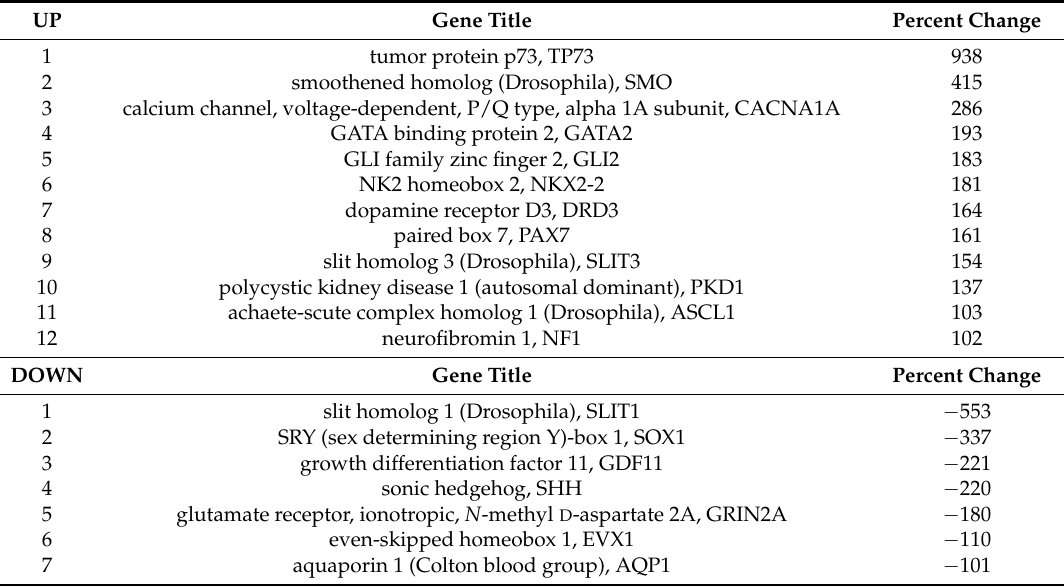
Table 30. GHK and Genes Associated with Spinal Nerve